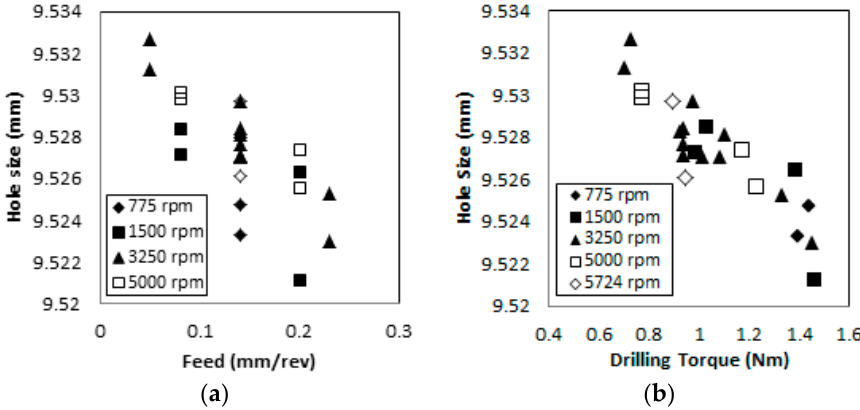
Figure 9. Effects of ( a ) feed and ( b ) maximum torque on the average hole size (drill diameter = 9.525 mm).